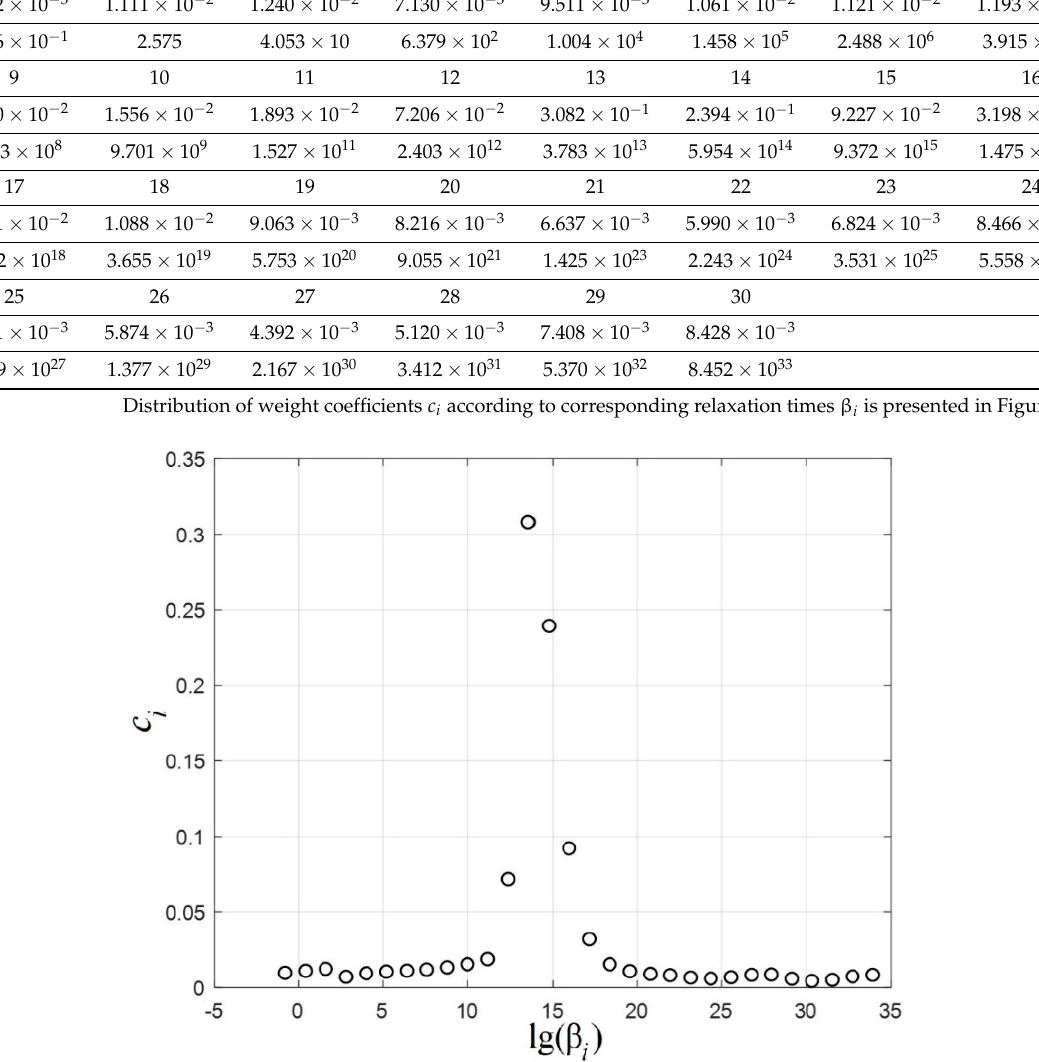
Figure 10. Distribution of weight coefficients 𝑐 (cid:3036) according to corresponding relaxation times β